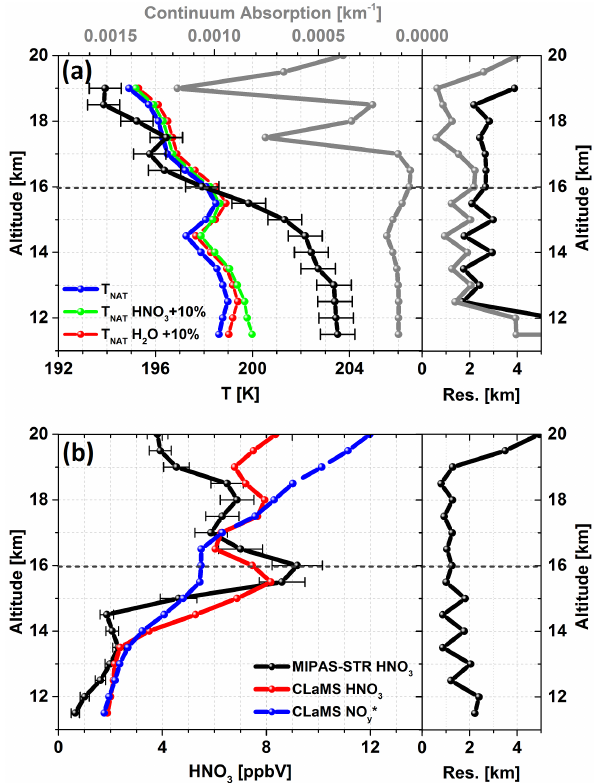
Figure 7. Upper panel (a) : temperature ( T ) and wave-number- independent background continuum absorption retrieved from MIPAS-STR for the limb scan at 08:32UTC. Corresponding pro- files of T NAT were calculated considering retrieved HNO 3 in combi- nation with the smoothed H 2 O profile from FLASH-A (alternative profiles considering increased HNO 3 and H 2 O are also indicated). Lower panel (b) : corresponding profiles of HNO 3 retrieved from MIPAS-STR and extracted from the CLaMS reference scenario to- gether with simulated passive NO ∗ y . Error bars on the left-hand side of the panels correspond to estimated total 1 σ uncertainties of the retrieval results. “Res.” on the right-hand side of the panels corre- sponds to vertical resolution of the retrieved profiles. Grey dashed lines indicate altitude with T equal to T NAT